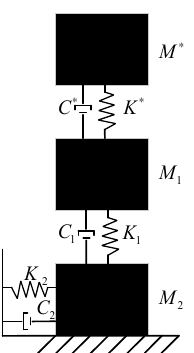
Figure 7. Simplified mechanical model of the storage tank.